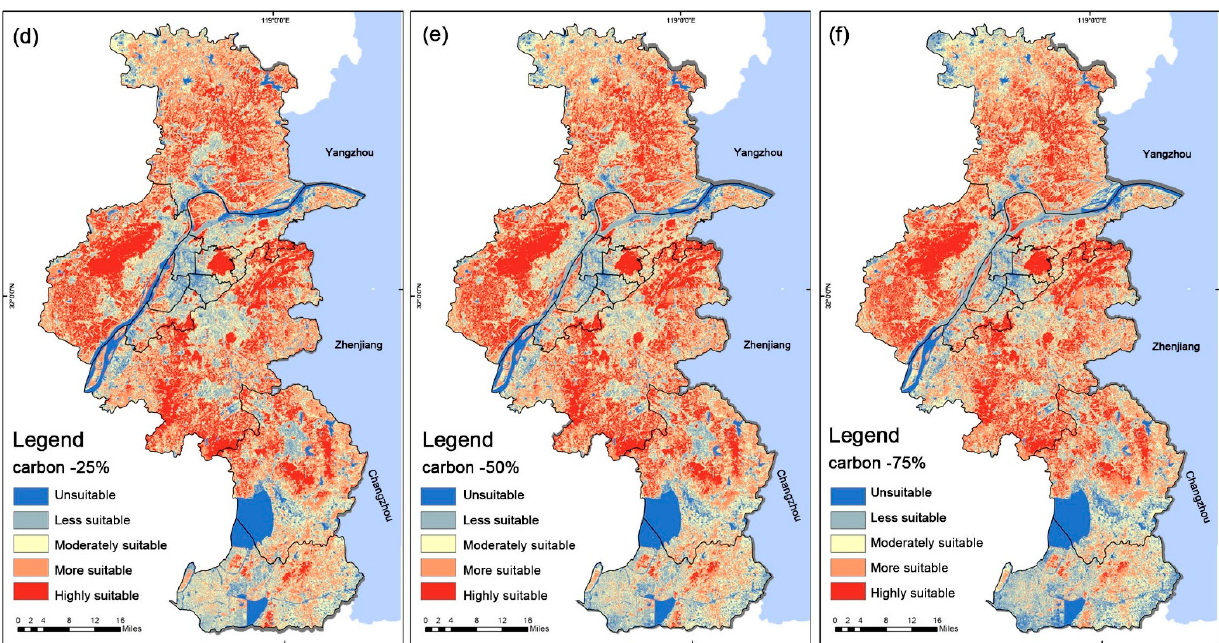
Figure 7. Results from sensitivity analysis from GIS for the criterion ‘carbon storage’ regarding About City Park Site Selection analysis: ( a ) Carbon 25%, ( b ) Carbon 50%, ( c ) Carbon 75%, ( d ) Carbon − 25%, ( e ) Carbon − 50%, ( f ) Carbon − 75%.